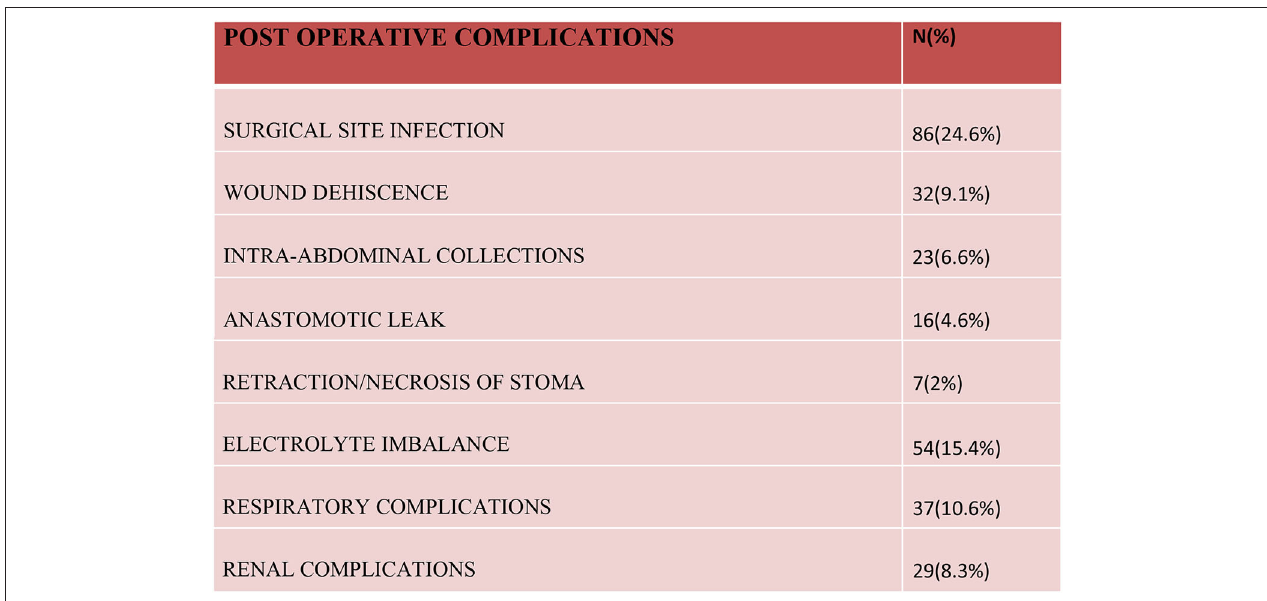
FIGURE 5 | Postoperative